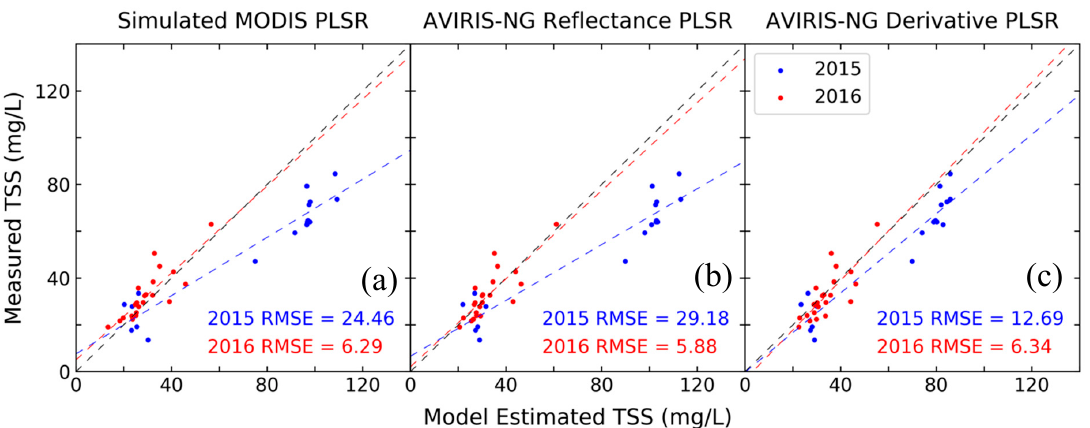
Figure 4. Validation scatterplots for the PLSR models applied to the 2015 and 2016 coastal Louisiana datasets: ( a ) simulated MODIS ocean color band reflectance, ( b ) AVIRIS-NG reflectance, and ( c ) AVIRIS-NG derivative.